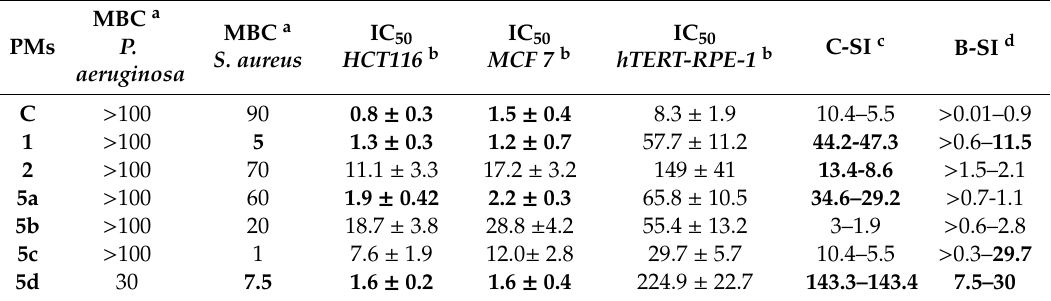
Figure 2. Kill curves of Staphylococcus aureus 25923 ( A ) and Pseudomonas aeruginosa 10145 ( B ) planktonic cells after challenge with increasing concentrations of PMs for 24 h. Table 1. Antibacterial activity and mammalian cell cytotoxicity of PMs (expressed in µ M) analysed in this study. In bold the best-obtained values of minimal bactericidal concentration (MBC), IC 50 , and selectivity indexes versus cancer cells or